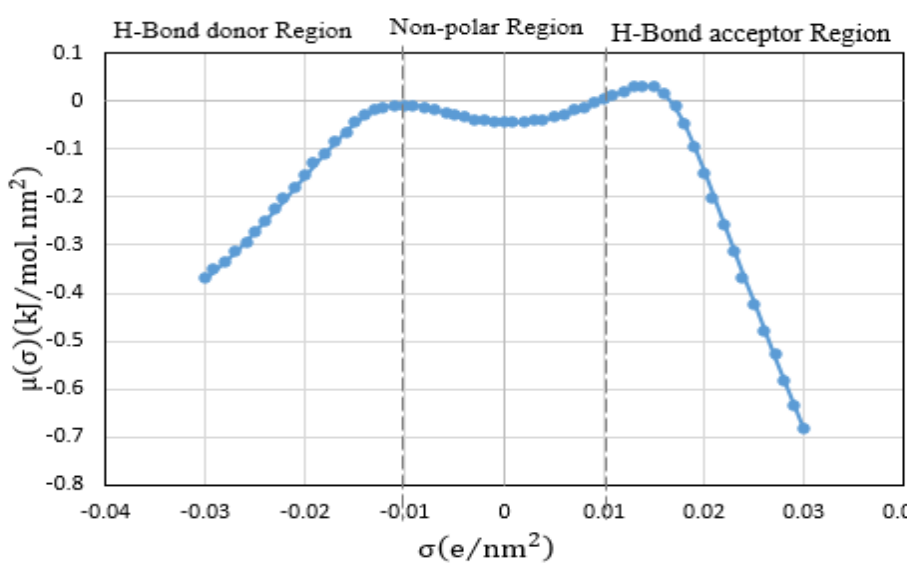
Figure 2. The σ -profile of EPA was obtained by COSMO-RS.